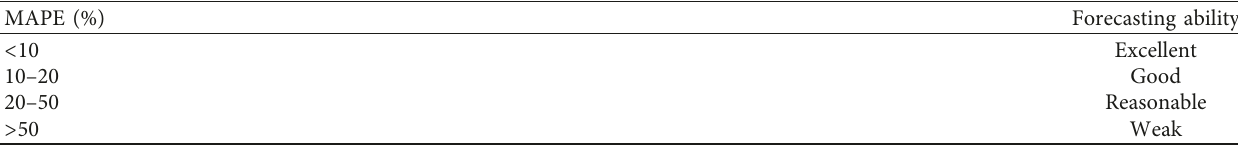
Table 4: The criteria for MAPE.